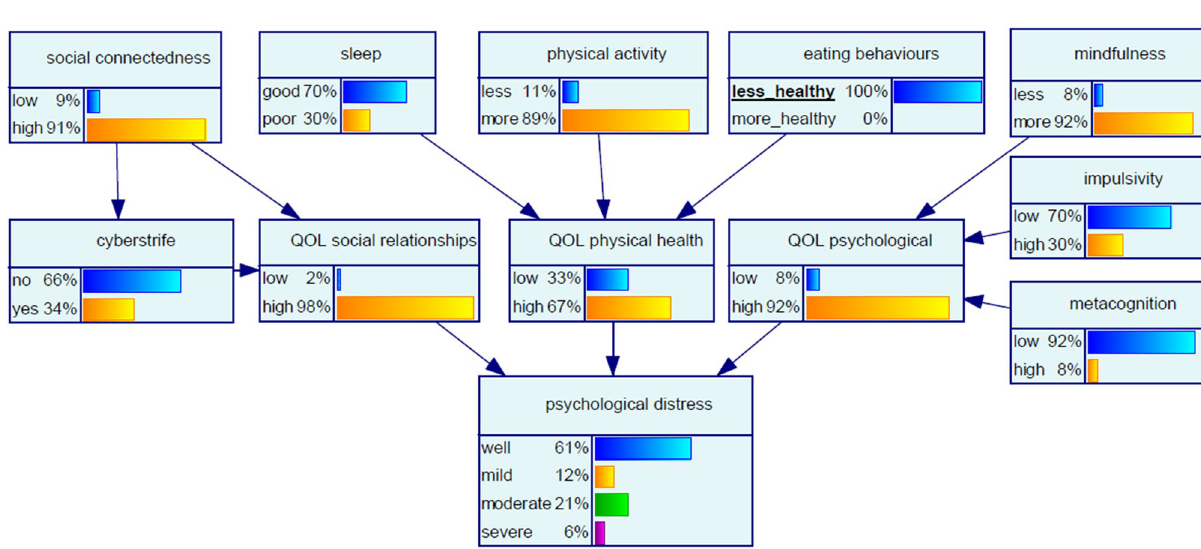
Figure 4. Bayesian network for Scenario 3 ‘certainty for less healthy eating